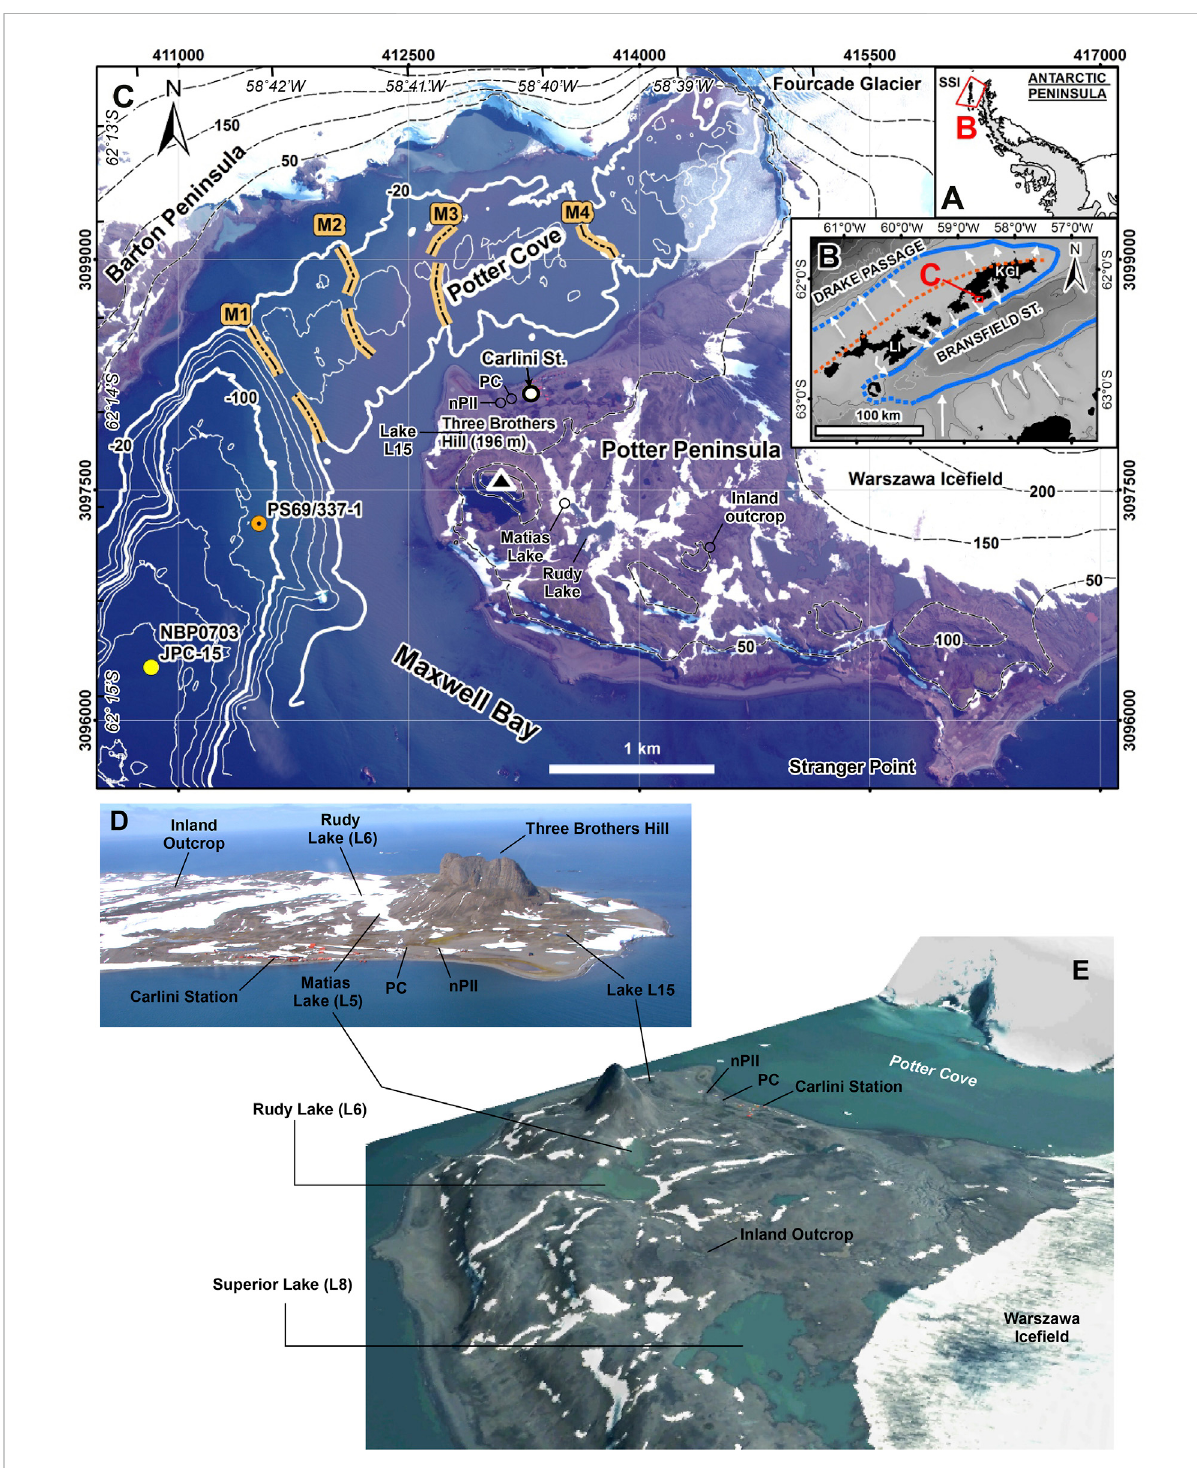
FIGURE 1 Location and geographic context of the study area. (A) Location of the South Shetland Islands (SSI) and (B) King George Island (KGI) and LivingstonIsland(LI).Bathymetriccontoursareevery500 m(Weatheralletal.,2015).NotetheextensionoftheLGMicecap(bluefullanddottedline) and its axis (red dotted line; after Simms et al., 2011). (C) Location and topography of Potter Peninsula and bathymetry of Potter Cove (adapted from Deregibus et al., 2015) and the positions of sedimentary cores and moraine complexes (NBP0703_JPC-15, Majewski et al., 2012; PS69/337-1, Wöl fl etal.,2016).MorainecomplexM4representsthepositionofFourcadeGlacierin1956(Wöl fl etal.,2016).Thepositionoftheicefrontonlandin